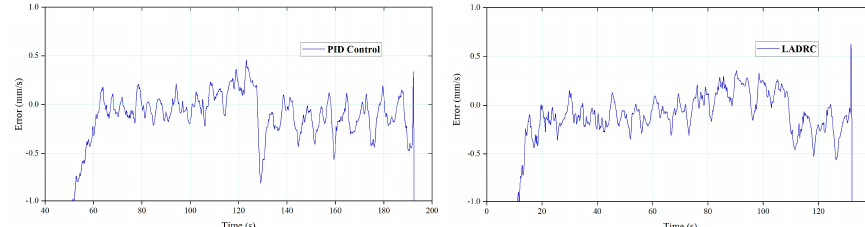
Figure 27. Speed error of cylinder #4 during unfolding.